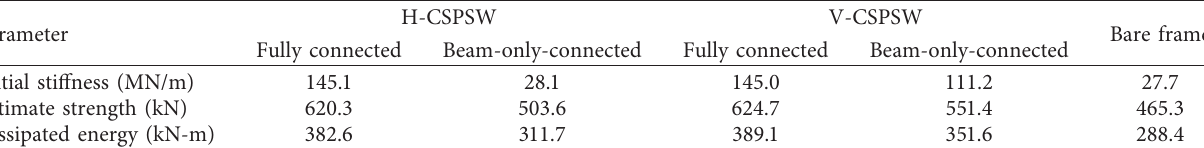
Table 4: Initial stiffness and ultimate strength for specimens.